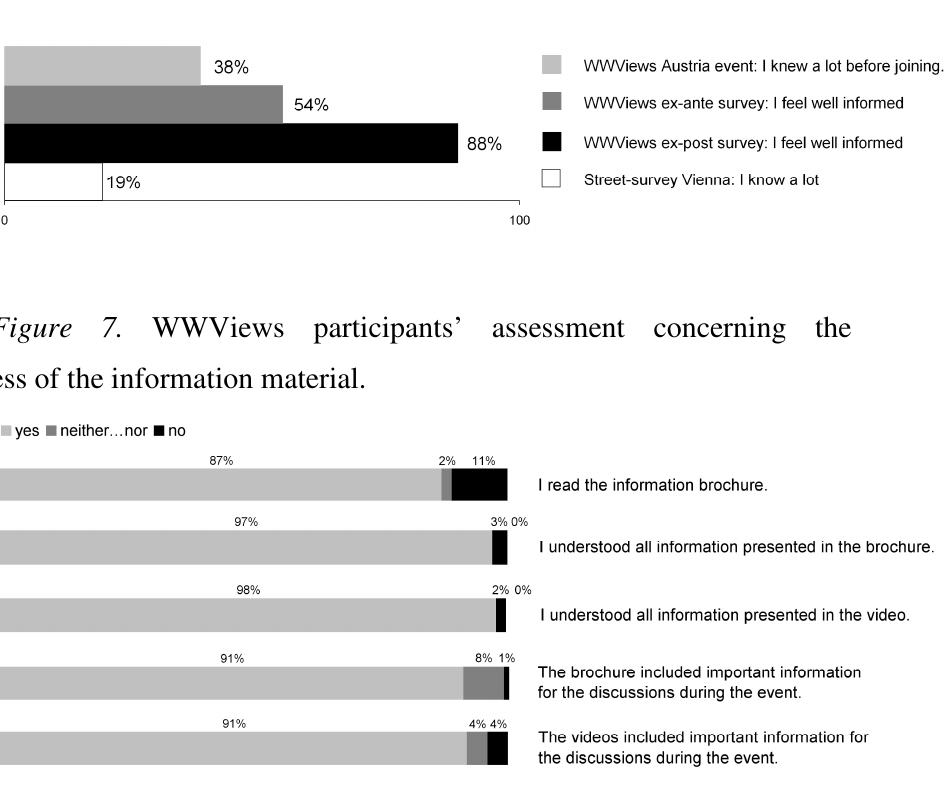
Figure 6. Comparison of results from WWViews Austria and a street survey in Vienna.